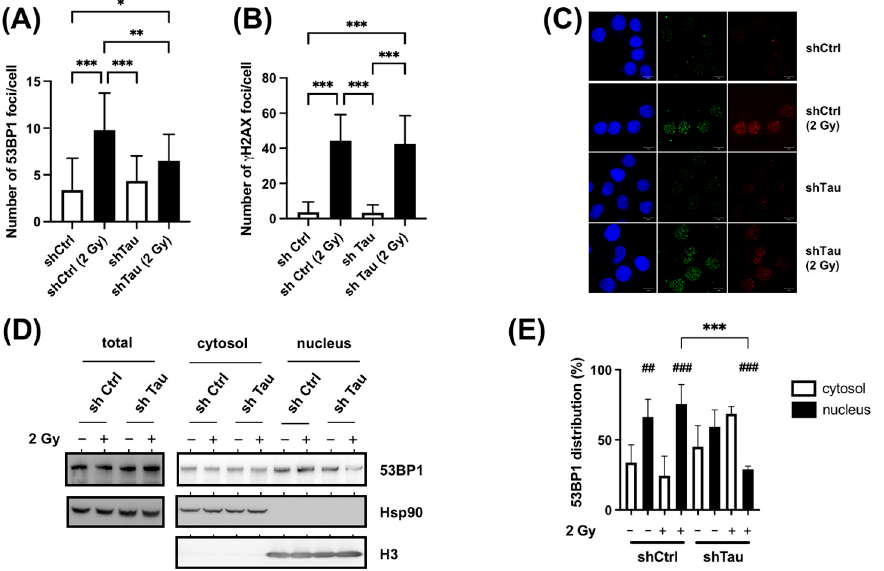
Figure 6. Tau increases 53BP1 nuclear translocation after X-ray treatment. ( A ). MCF7 shCtrl and shTau cells were irradiated with 2 Gy exposure and then further incubated for 15 min. Cells were then labeled with a 53BP1 antibody, and the number of 53BP1 foci per cell (n > 50) was determined using Image J. All experiments were carried out in three independent experiments. Data are mean ± SD * p < 0.05; ** p < 0.01; *** p < 0.001. ( B ) MCF7 shCtrl or shTau stable clones were irradiated with 2 Gy and then further incubated for 15 min. Cells were then labeled with a γ -H2AX antibody to quantify DNA double-strand breaks, and the number of γ -H2AX foci per cell (n >50) was determined using Image J. All experiments were carried out three independent experiments. Data are mean ± SD *** p < 0.001. ( C ) Representative images of 53BP1 (red) and γ -H2AX (green) staining in MCF7 shCtrl or shTau stable clones irradiated or not with 2 Gy and further incubated for 15 min. ( D ) Total extraction and subcellular fractionation of MCF7 shCtrl and shTau cells 15 min after X-ray treatment was followed by western blots to monitor the levels of 53BP1 in the cytoplasm and nucleus. HSP90 was used as a marker of total and cytoplasmic fractions, and histone H3 as a marker of the nuclear fraction. ( E ) The graph shows the quantification of four independent experiments from C. Data are mean ± SD * p < 0.05; ** p < 0.01; *** p < 0.001. ## p < 0.01; ### p < 0.001 compared to the corresponding cytoplasmic